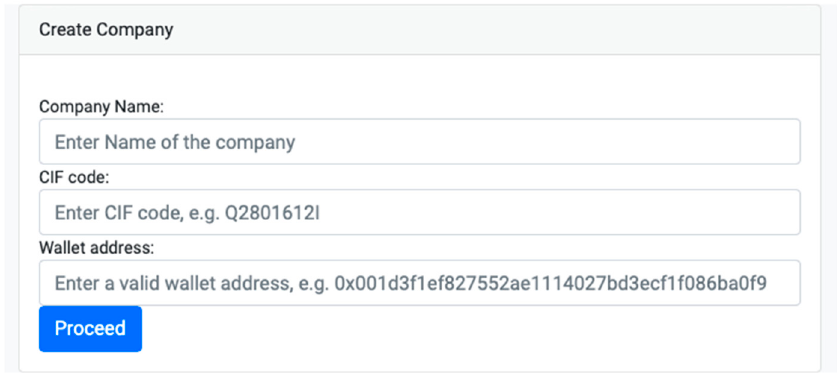
Figure 7. Company creation example.